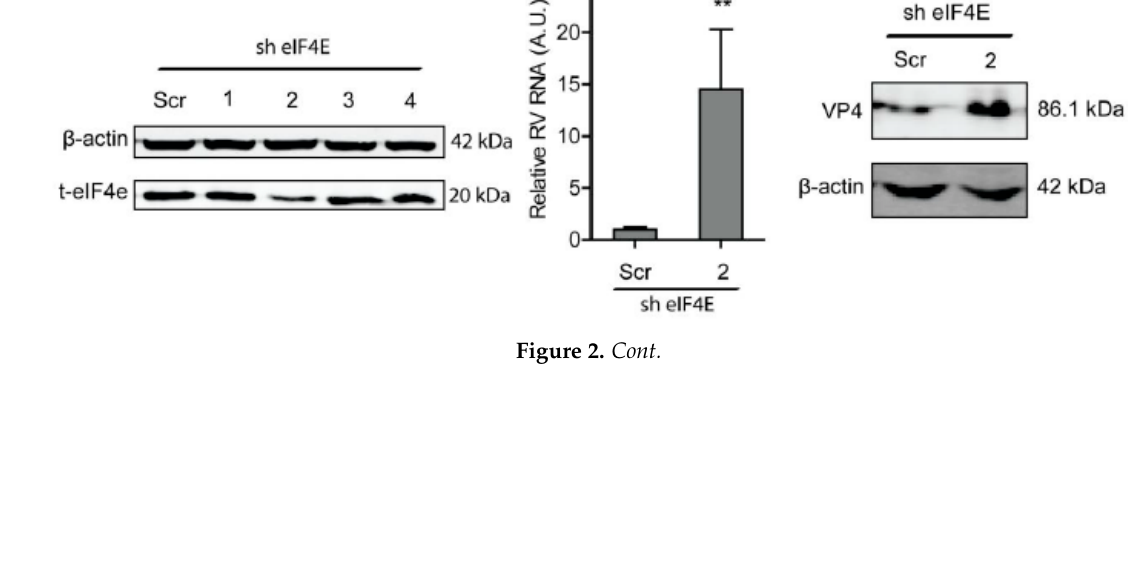
Figure 2. The eIF4E suppresses rotavirus infection. ( A ) Western blot assay measured the eIF4E protein in Caco2 cells transduced lentiviral RNAi vectors against eIF4E, indicating that one out of three shRNA vectors exerted a potent knockdown. ( B ) The knockdown of eIF4E significantly promoted rotavirus genomic RNA ( n = 6, ** P < 0.01, Mann–Whitney test). ( C ) Western blot assay confirmed that eIF4E knockdown increased rotavirus protein level. ( D ) The eIF4E was knocked out by CRISPR/Cas9 assay. ( E ) Silence of eIF4E by CRISPR/Cas9 increased the rotavirus RNA level ( n = 6, * P < 0.05, Mann– Whitney test). ( F ) Silence of eIF4E by CRISPR/Cas9 increased the rotavirus VP4 protein level. 2.3. The eIF4G Suppresses Rotavirus Infection As a scaffolding protein, eIF4G protein is able to physically link mRNA and the small ribosomal subunit via protein-protein interactions. To investigate the effects of eIF4G protein on rotavirus infection, a lentiviral shRNA-mediated loss-of-function assay was conducted, which resulted in gene silence of eIF4G by all five shRNA vectors at both the mRNA and protein level (Figure 3A,B). Importantly, all these shRNA vectors resulted in a potent increase in the viral RNA and protein level (Figure 3C,D). The vitality of cells was not affected by these shRNA vectors (Supplementary Figure 2C). To further verify these findings, we performed a Crispr/cas9 assay to knockout eIF4G in Caco2 cells (Figure 3E). After gene knockout, the viral RNA and protein levels were inhibited (Figure 3F,G).